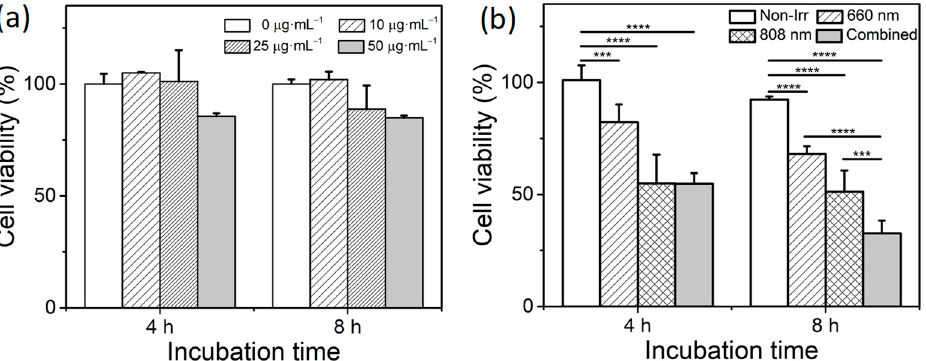
Figure 6. ( a ) Cytotoxicity of GO–FA/Ce6 on MCF-7 cells and ( b ) comparison of MCF-7 viability fol- lowing PTT, PDT and combined phototherapy after the incubation with GO-FA/Ce6 (at 25 μ g ∙ mL − 1 ) for 4 and 8 h. MCF-7 cells incubated with GO–FA/Ce6 (at 25 μ g ∙ mL − 1 ) for 4 and 8 h (Non-Irr) were used as control. The results are expressed as the means ± SD ( n ≥ 3). The statistical analyses were performed by the Student’s t -test. * p < 0.05; ** p < 0.01; *** p < 0.001; **** p < 0.0001 compared with two groups.